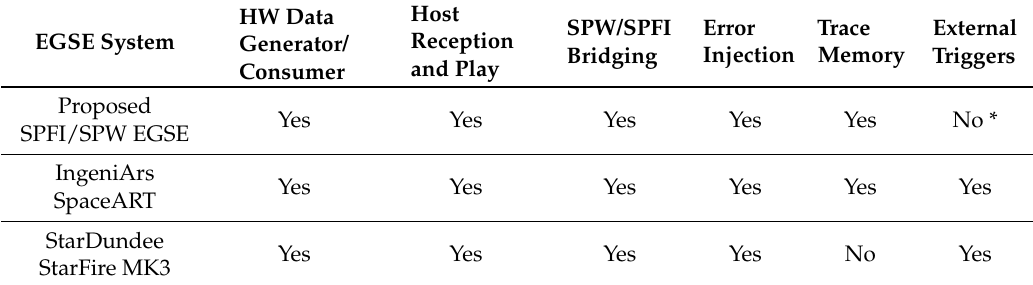
Table 3. Comparison table of the available SpaceFibre EGSE solutions by capabilities: in-hardware packet generation/consumption, data record, and playback from remote host, SPFI/SPW cross bridging, link error injection, tracing memory, external trigger signals for